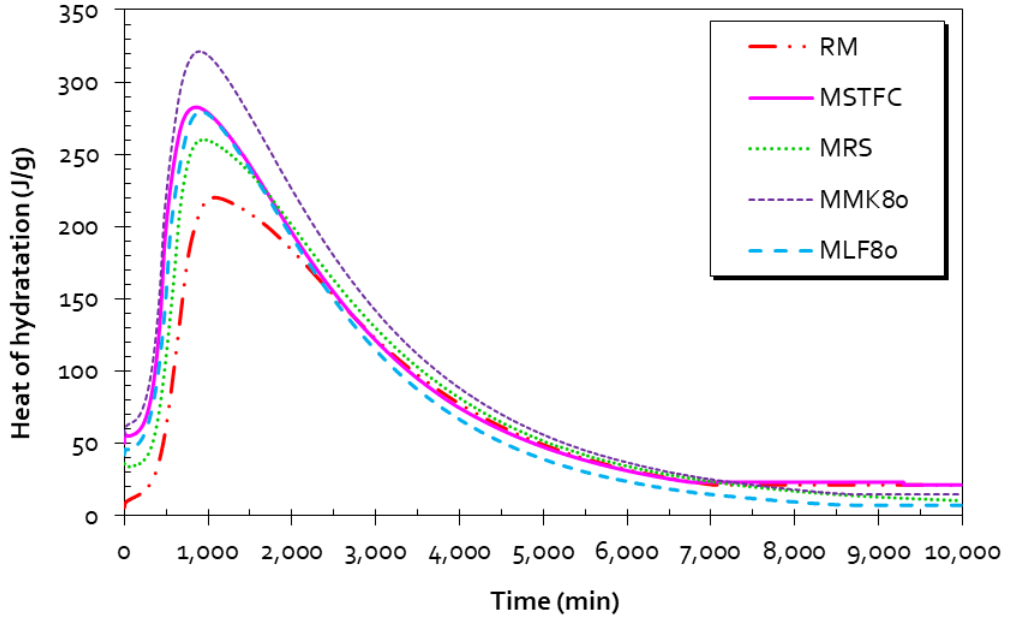
Table 6. Mortar composition of RM, MRS, and MSTFC for the heat of hydration test (NF EN 196-9) [50].